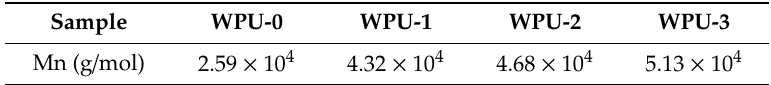
Table 2. Molecular weight of WPU samples prepared using different amount of APTS.